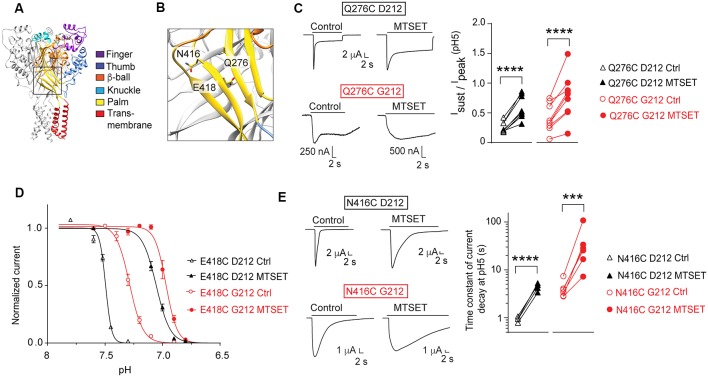
Conserved effects of mutations in the palm. All experiments of this figure are from hASIC1a expressed in Xenopus oocytes, voltage-clamped to −60 mV. (A,B) Overview and detailed image of a structural model of hASIC1a, based on the crystal structure of cASIC1a (Baconguis et al., 2014). The domains of one subunit are indicated by different colors, as in Figure 1A. (C) Left, representative current traces of the mutant Q276C in the background of hASIC1a-D212 (top) or -G212 (bottom), as indicated, before and after MTSET exposure (1 mM, 3 min). ASIC currents were induced by changing from the conditioning pH7.4 to the stimulation pH5.0. Right, the Isust/Ipeak ratio at pH5.0 (n = 8–10) is shown. For Q276C D212C, the Isust/Ipeak ratio was measured during the last 2 s of the acid perfusion; the duration of the pH5.0 perfusion was the same in the control and MTSET condition. For Q276C G212, this ratio was measured at 16–18 s after the start of the pH5.0 perfusion. (D) SSD pH dependence of the mutant E418C before (open symbols) or after MTSET exposure (filled symbols, 1 mM 3 min, n = 4–7). Normalized current amplitudes are plotted as function of the conditioning pH. Two-way ANOVA showed that MTSET induced an acidic shift of the pH dependence in both backgrounds (p < 0.0001). (E) Left, representative current traces of the mutant N416C in the background of hASIC1a-D212 (top) or -G212 (bottom), before and after MTSET exposure (1 mM, 3 min). ASIC currents were induced by changing from the conditioning pH7.4 to the stimulation pH5.0. Right, the time constant of the current decay measured at pH 5.0, is shown before and after exposure to MTSET (n = 5–6). For (C,E), ***p < 0.001; ****p < 0.0001; paired t-test.